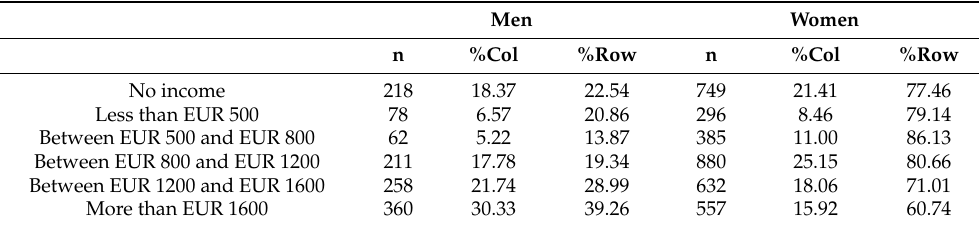
Table 4. Monthly salary and gender.